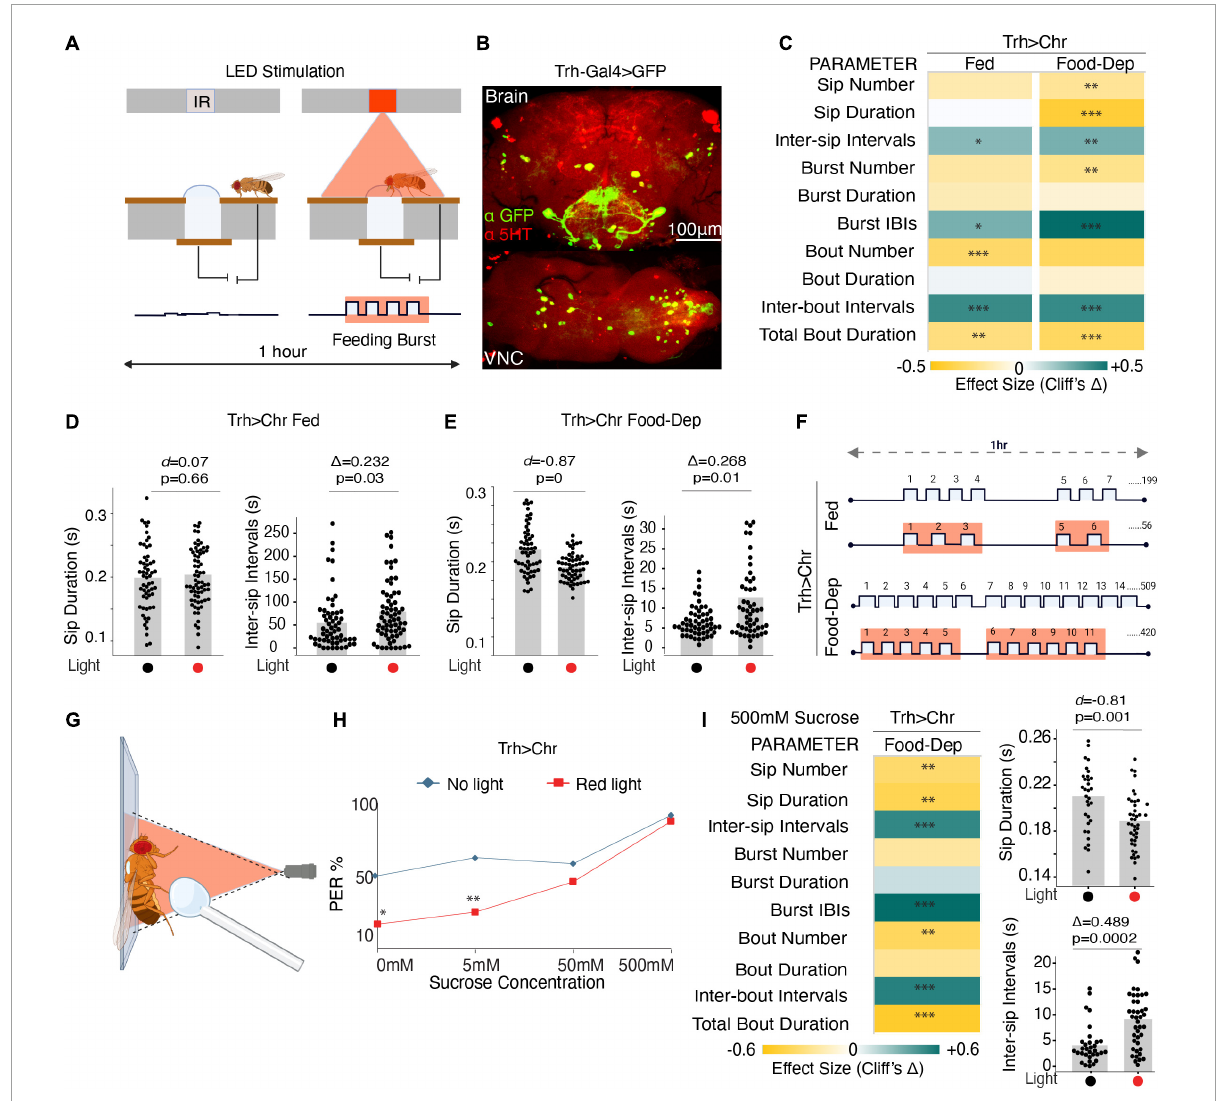
FIGURE2 Optogenetic activity in the broad serotonin system suppresses feeding. (A) Schematic depicts the closed-loop OptoPAD system used for optogenetic activation of serotonergic neurons as the fly starts to feed. The light stimulation is provided for 2 s after the start of an activity bout. (B) Maximum intensity projections of Trh-Gal4 driven expression of mcD8:GFP and immunostained with anti-5HT antibody to mark the serotonergic neurons in the fly brain and VNC. (C) Heat map showing Cliff’s (cid:49) effect size for all the parameters measured by the OptoPAD system for Trh-Gal4 > UAS-Chrimson in the fed (left) and the food-deprived state (right). (D) Estimation plot showing Cohen’s d for mean sip durations and Cliff’s (cid:49) for inter-sip intervals for fed Trh-Gal4 > UAS-Chrimson flies with and without optogenetic activation during the assay time (3,600 s) ( n = 60–70). Optogenetic activation of Trh-expressing neurons increased the inter-sip intervals [ n = 57–65, (cid:49) = 0.232 (95% CI 0.026, 0.422), p = 0.03]. (E) Estimation plot showing the Cohen’s d for mean sip durations and inter-sip intervals of food-deprived Trh-Gal4 > UAS-Chrimson flies with and without optogenetic activation during the assay time (3,600 s). Activation of Trh-expressing neurons reduced sip duration [ n = 56–57, d = –0.87, (95% CI, –1.23, –0.52), p < 0.001] and increased the inter-sip intervals [ n = 55–56, (cid:49) = 0.268 (95% CI 0.04, 0.47), p = 0.01]. (F) Representative schematic comparing the changes in feeding microstructure parameters with the optogenetic activation of Trh-Gal4 > UAS-Chrimson flies compared with controls without activation for both fed and food-deprived states. An average number of sips is shown; sip durations, and intervals indicate changes not drawn to scale. (G) Schematic depicting the PER assay with optogenetic manipulation. (H) PER response in red light illuminated Trh-Gal4 > UAS-Chrimson flies is decreased when presented with water (0 mM sucrose) ( n = 24, p = 0.014) and 5 mM sucrose ( n = 24, p = 0.008) compared to non-light activated controls. (I) (Left) Heat map showing Cliff’s (cid:49) effect size for all the parameters measured by the OptoPAD system using 500 mM sucrose as the food source. (Right) Estimation plots show Cohen’s d for sip duration and Cliff’s (cid:49) for inter-sip intervals for 500 mM sucrose. There is a significant reduction in sip durations [ n = 32–42, d = –0.81 (95% CI –1.34, –0.27), p = 0.001] and an increase in intervals between them [ n = 32–41, (cid:49) = 0.489 (95% CI 0.201, 0.683), p = 0.0002]. All optogenetic activation experiments were performed at 140 µ W/mm 2 . In the heatmap, green indicates an increase in effect size, and yellow indicates a decrease in effect size. p -values for the effect size measure are indicated with an asterisk ∗ p < 0.05, ∗∗ p < 0.01, and ∗∗∗ p <